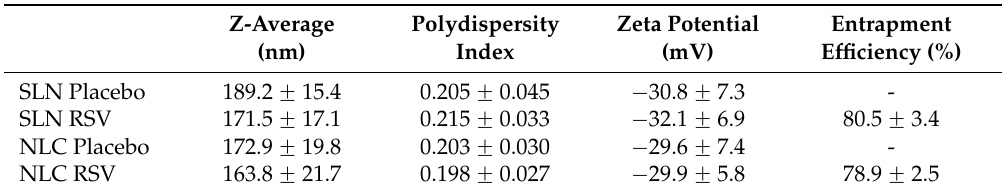
Table 1. Characterization of resveratrol-loaded solid lipid nanoparticles (SLNs) and nanostructured lipid carriers (NLCs).